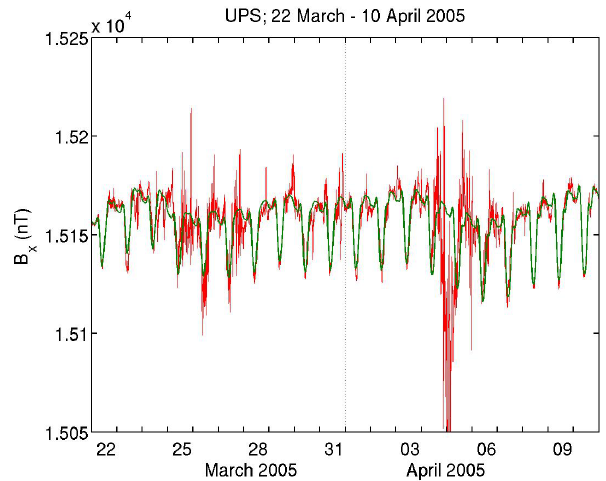
Fig. 9. B x field at Uppsala from 22 March to 10 April 2005 (red), and the corresponding baseline derived as described in this paper (green).